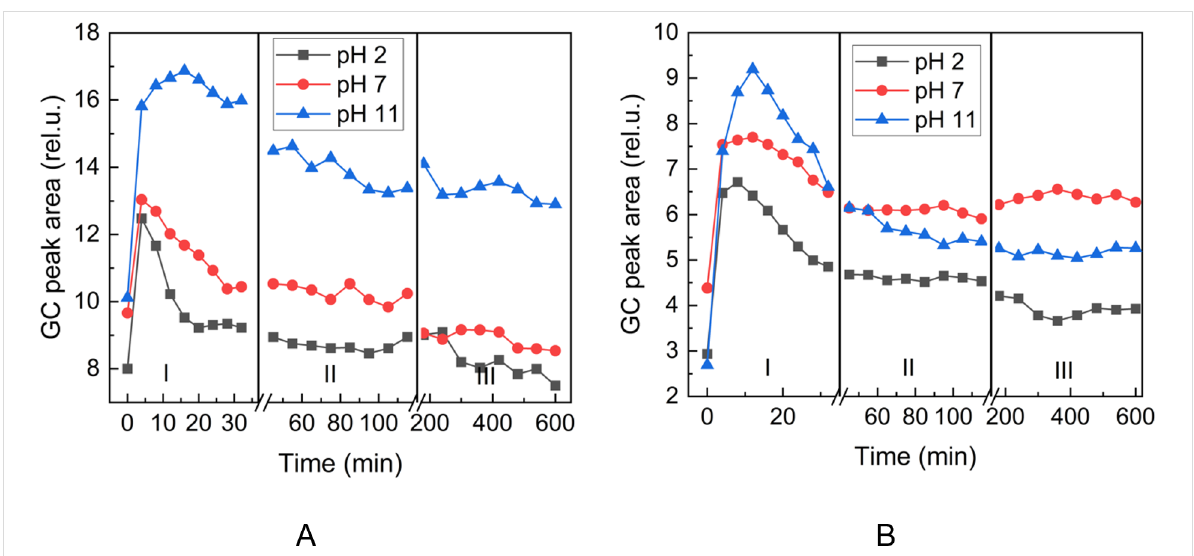
Figure 7: Time evolution of the headspace concentration of 5-methylfurfural ( 2j ) after successive extractions from the gaseous phase above (A): 5-methylfurfural ( 2j ) in aqueous phosphate buffers and (B): 5-methylfurfurylimino- β -CD ( 3j ) in aqueous phosphate buffers. Sampling intervals in the corresponding regions: I – 4 min, II – 10 min, III – 60 min.